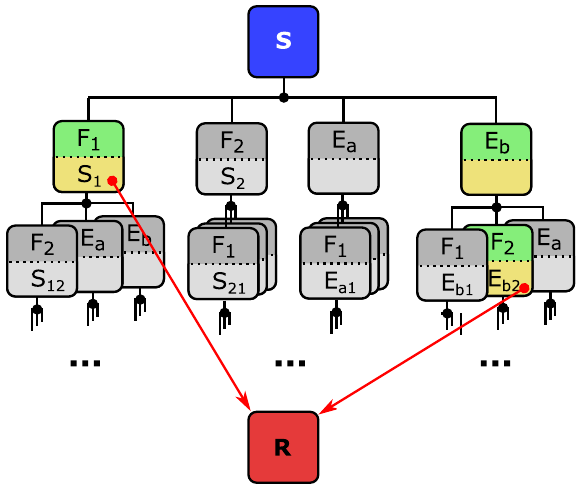
Figure 7. Ordered propagation with the source being the root of the tree. The environment consists of two faces F 1 and F 2 as well as of two half-edges E a and E b . Each node contains one mesh item which can be either a face or a half-edge. Faces can additionally be linked to further image sources or image edges depending on the position of the node in the tree. The receiver is connected to colored items that represent a valid path, grey- scale items are not forming valid